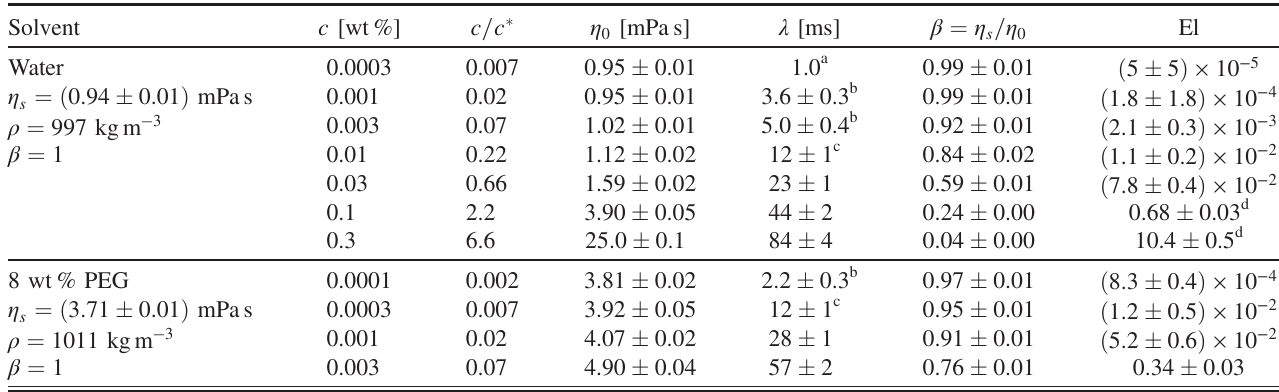
a Relaxation time estimated from the Zimm formula [Eq. (2)]. b Relaxation time measured using the slow retraction method (SRM) implemented on a capillary breakup extensional rheometer (CaBER). c Relaxation time measured using both standard CaBER and SRM techniques. d Representative El for the fluid calculated based on the zero shear viscosity η